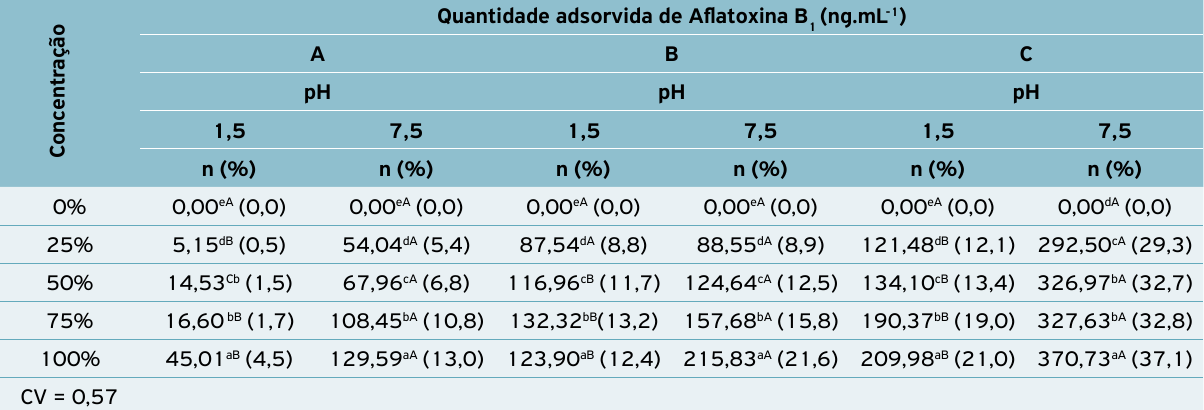
Tabela 2. Valores e percentuais de adsorção de 1.000 ng.mL ‑1 de aflatoxina B de produtos comerciais utilizados na alimentação